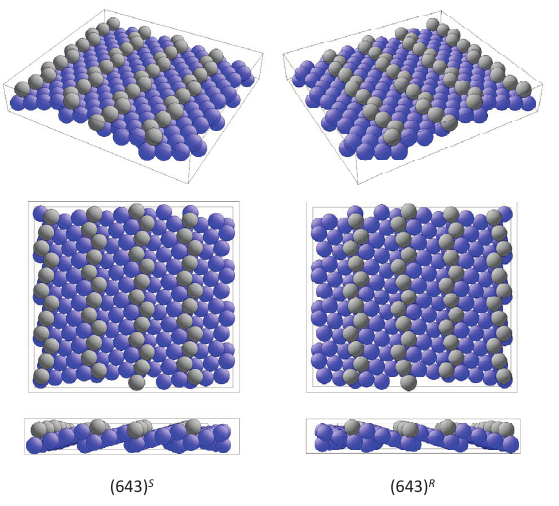
Figure 11. The chiral fcc ( 643 ) surface. The two modifications fcc ( 643 ) S and fcc ( 643 ) R with opposite handedness from different perspectives are shown. Different colors are used to better distinguish edge and kink atoms from those on